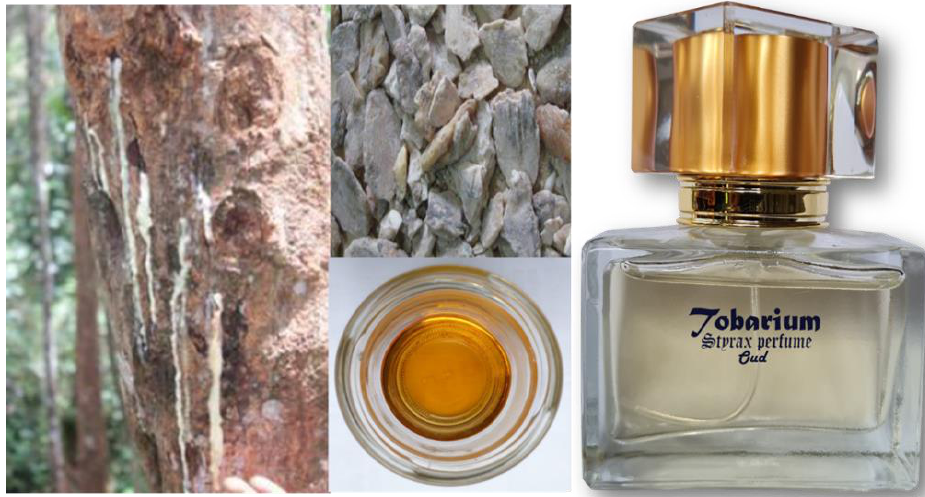
Figure 2. Resin processing and product innovation of benzoin.